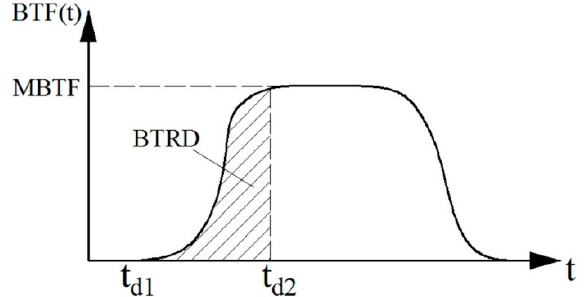
Figure 6. Typical curve of the bending and twisting load, MBTF: maximum bending and twisting load; BTRD: bending and twisting rigidity descending; BTF: bending and twisting load vs. time; t d 1 : time when the upper measuring head just touches the sample during the descending process; t d 2 : the time when the upper measuring head reaches the lowest position